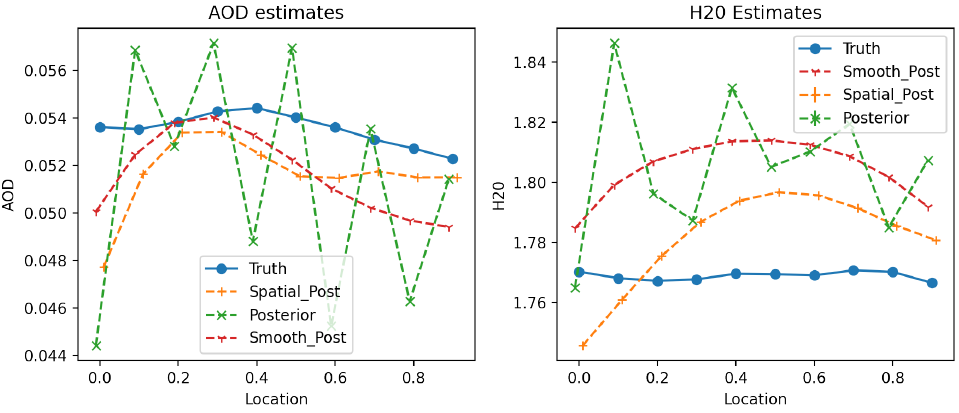
Figure 2. Inversions of simulated data showing the water vapor (units of g/cm 2 ) and aerosol optical depth estimates across 10 pixels in 1D. The retrieved fields are more realistic for spatial (Spatial_Post) than for individual retrievals (Posterior). The post-hoc smoothing (Smooth_Post) can improve the individual retrievals but cannot overcome the